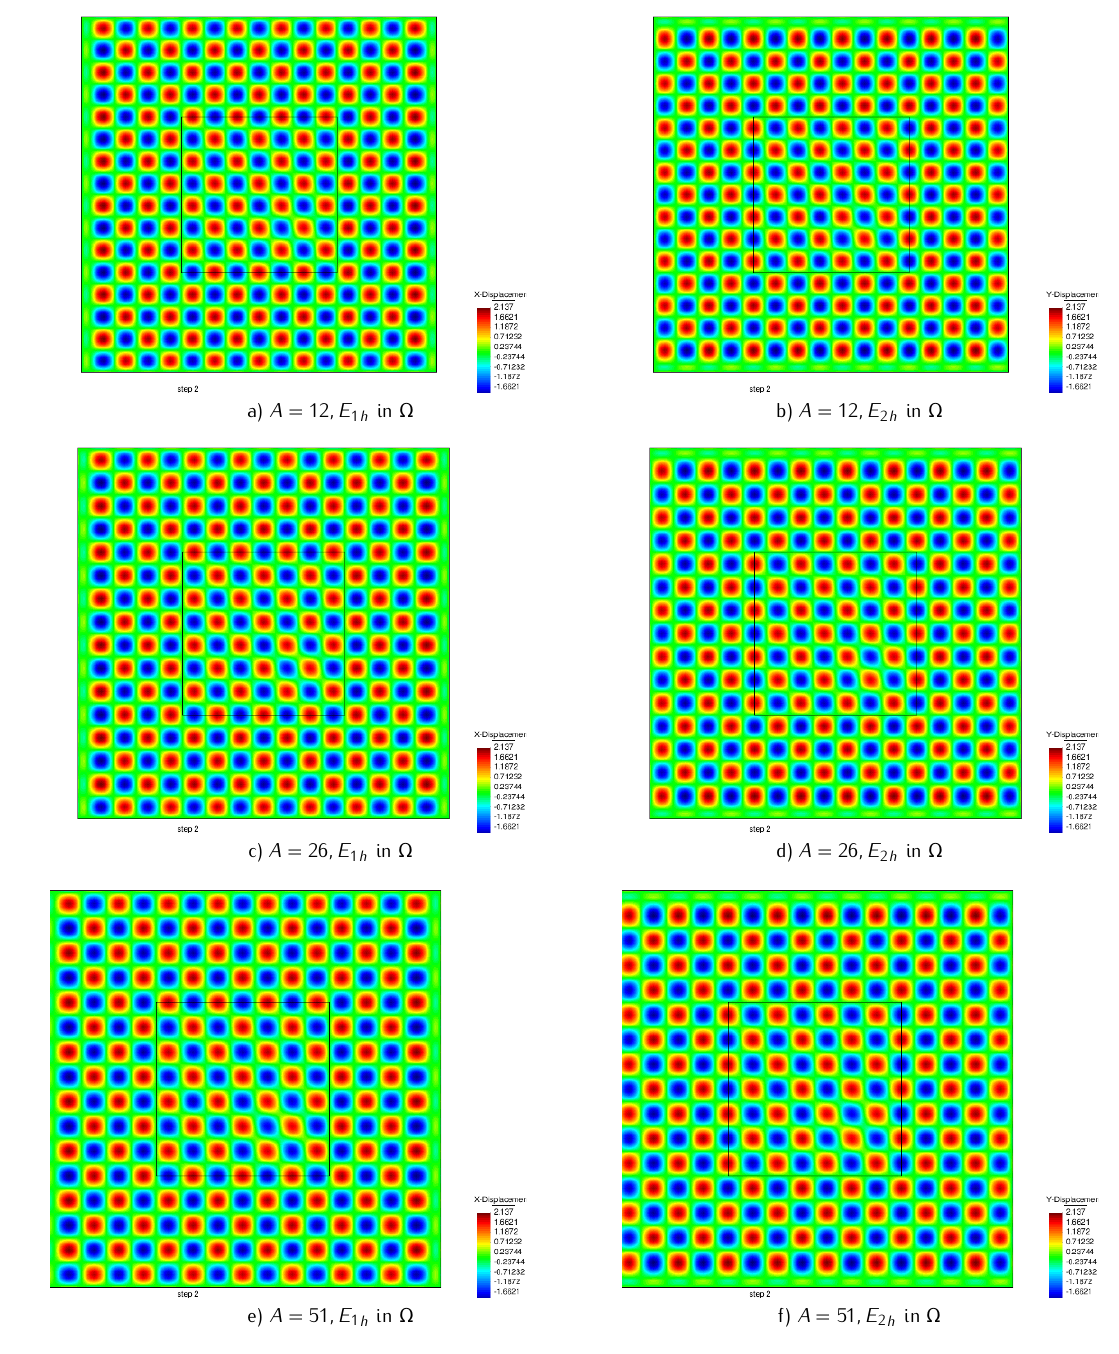
Figure 6. Test 1. Computedsolutions E h = ( E 1 h ,E 2 h ) inthe domaindecompositionFEM/FDMattime moment t = 4 . 0 in Ω . Weshow comparisons of the computed solutions versus different values of the coefficient ε ( x ) inside Ω for Maxwell’s equations: in a) and b) the amplitude FEM A = 26 in (46) ; in c) and d) the amplitude A = 51 in (46)